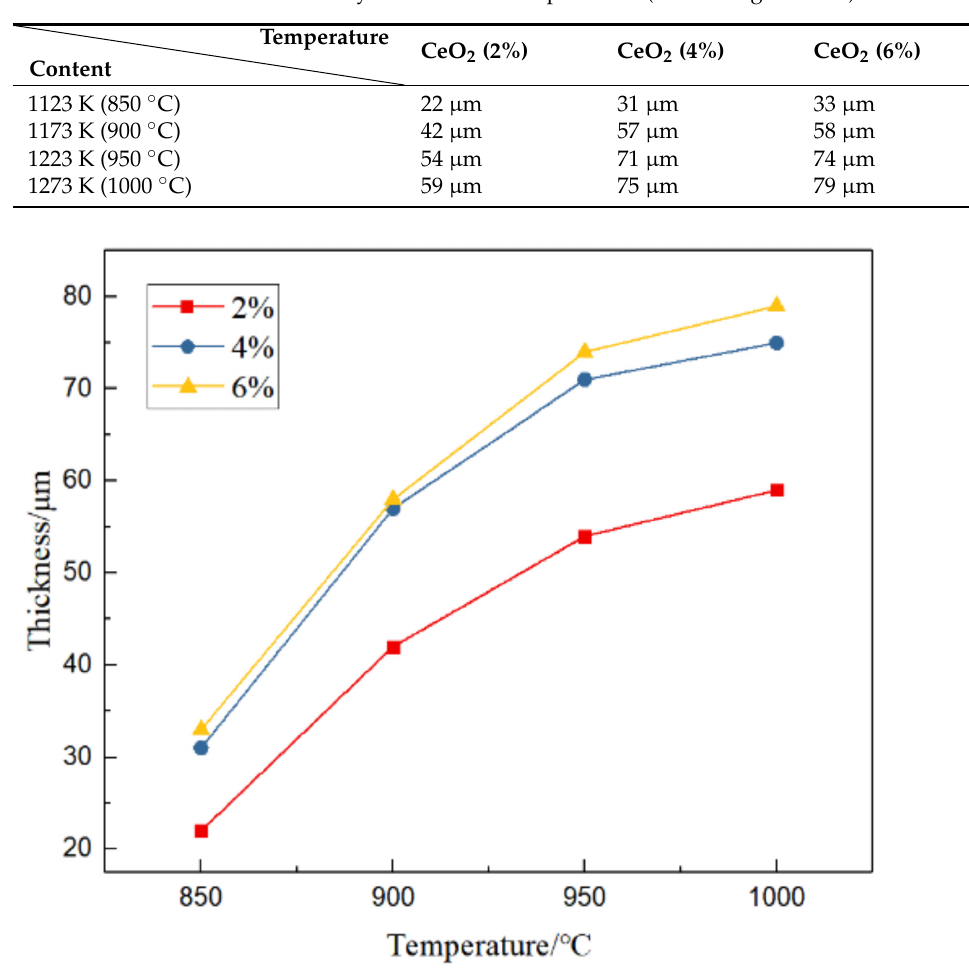
Table 5. Thickness of infiltration layer at different temperatures (Boronizing time 4 h).